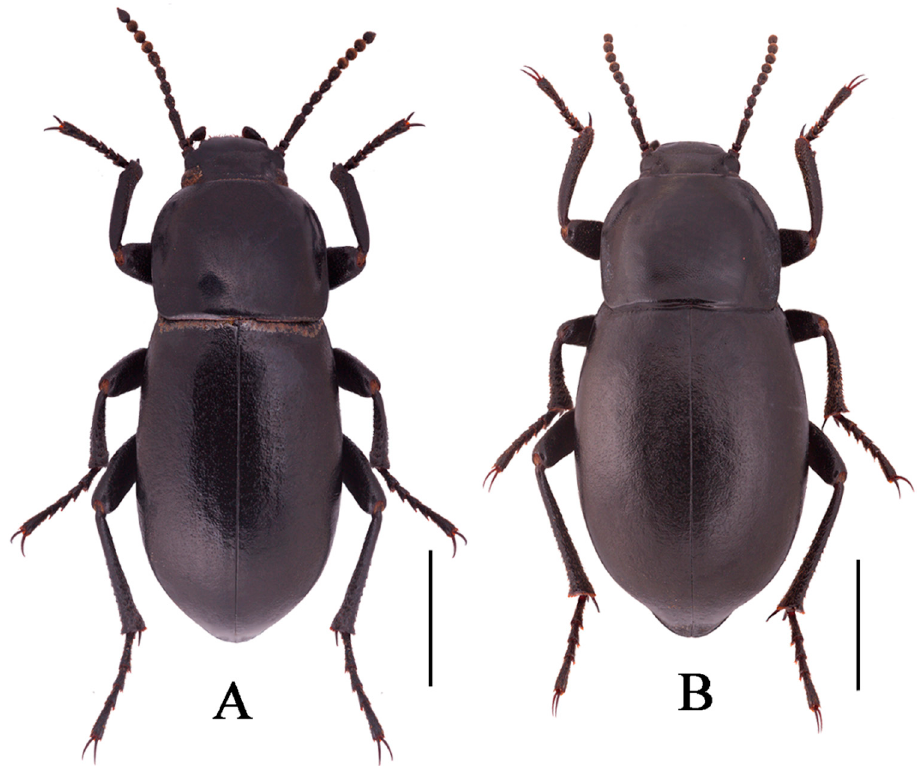
Figure 4. Habitus of N. quadrata Li & Ren, sp. n. (( A ) male, holotype; ( B ) female, paratype). Scale bars: 5.0 mm.